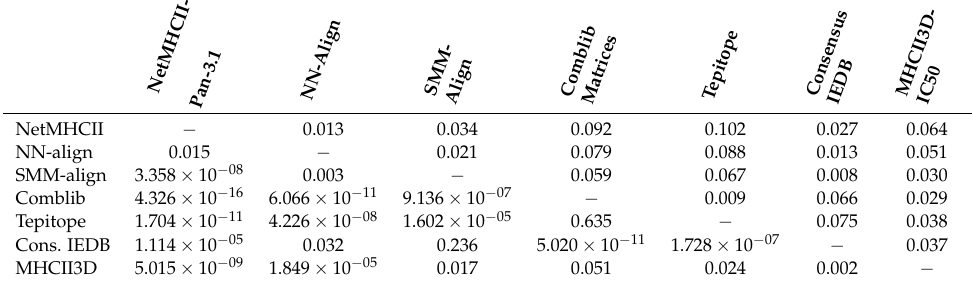
Table 3. Statistical analysis of the ROC curves presented in Figure 1. The prediction methods are compared in terms of ∆ AUC values (upper triangle) and p -values (lower triangle), computed by the StAR [35] software tool.